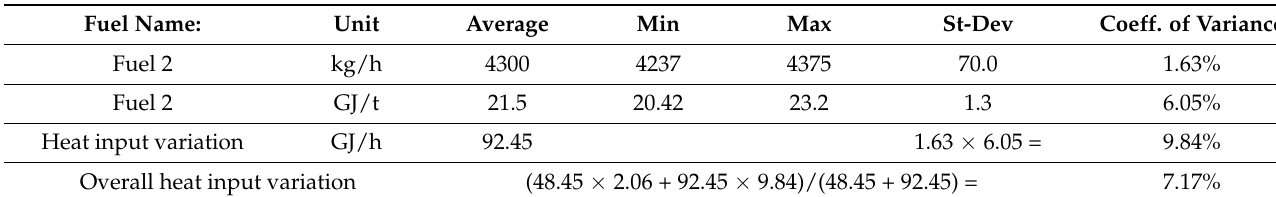
Table 4. Heat input variation calculation for two-fuel